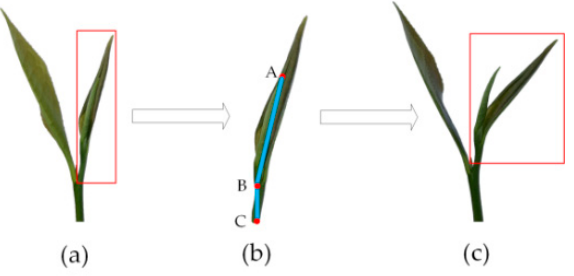
Figure 4. Tea shoot branching ( a ), terminal bud ( b ) and the new tea shoot branching produced by the terminal bud ( c ).